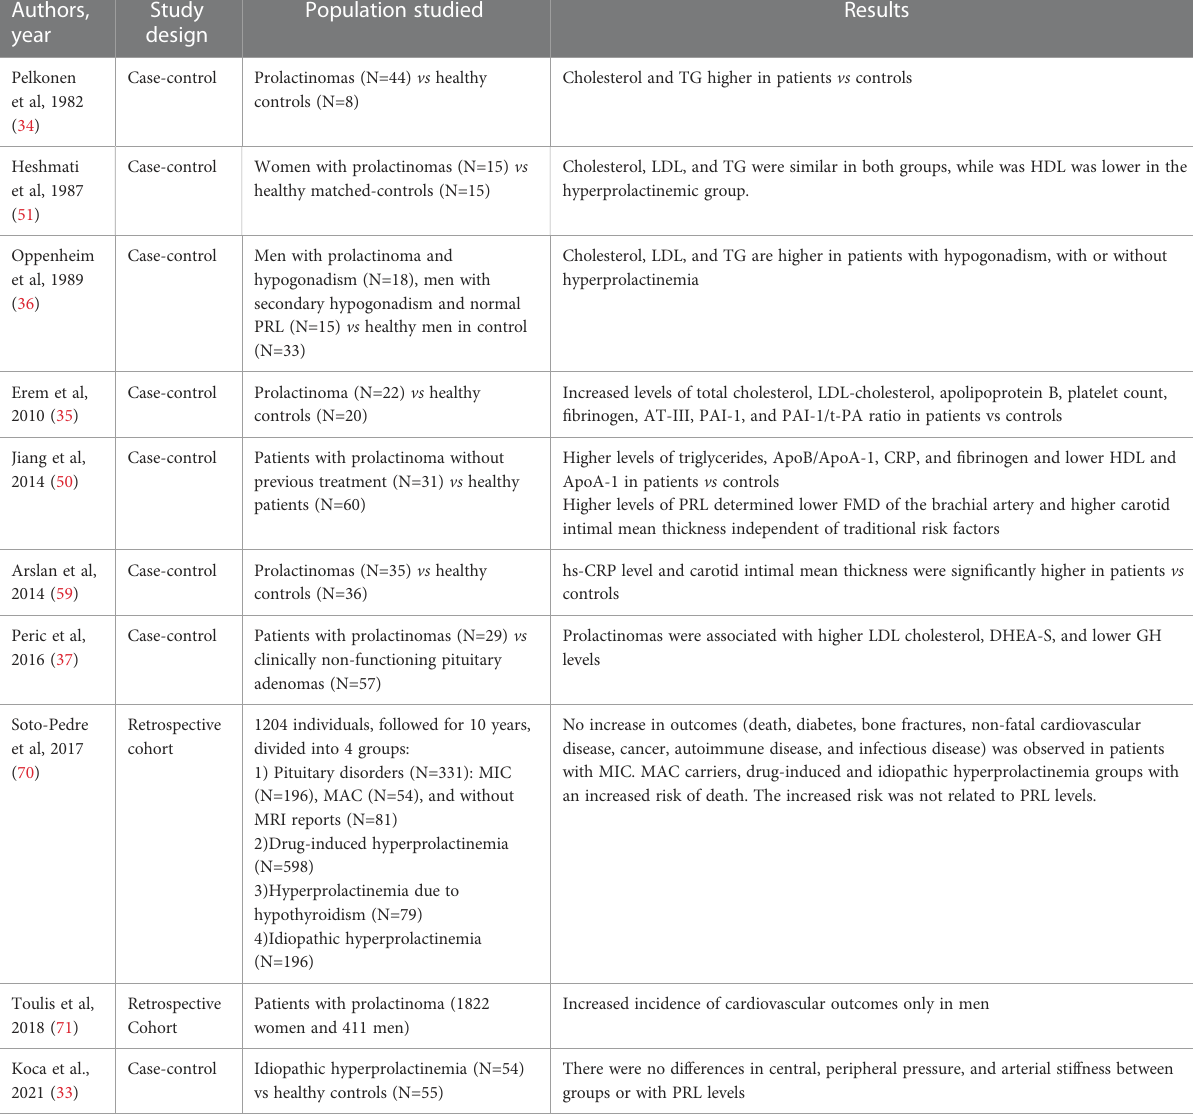
TABLE 1 Studies with patients with hyperprolactinemia/prolactinoma without using